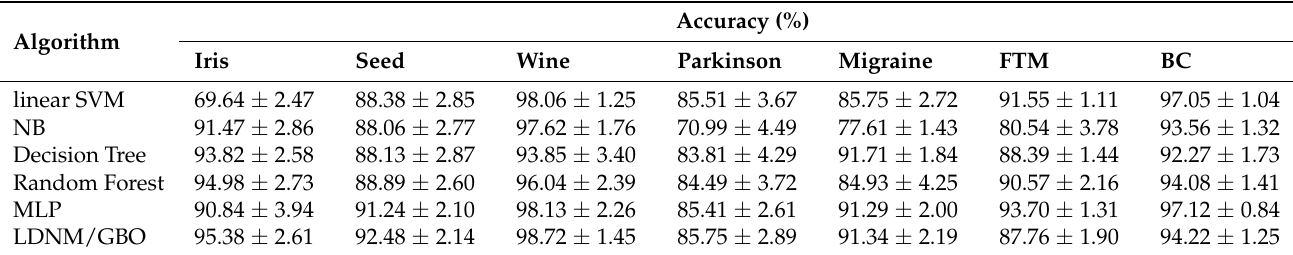
Table 5. Classification results of LDNM/GBO and other classifiers.